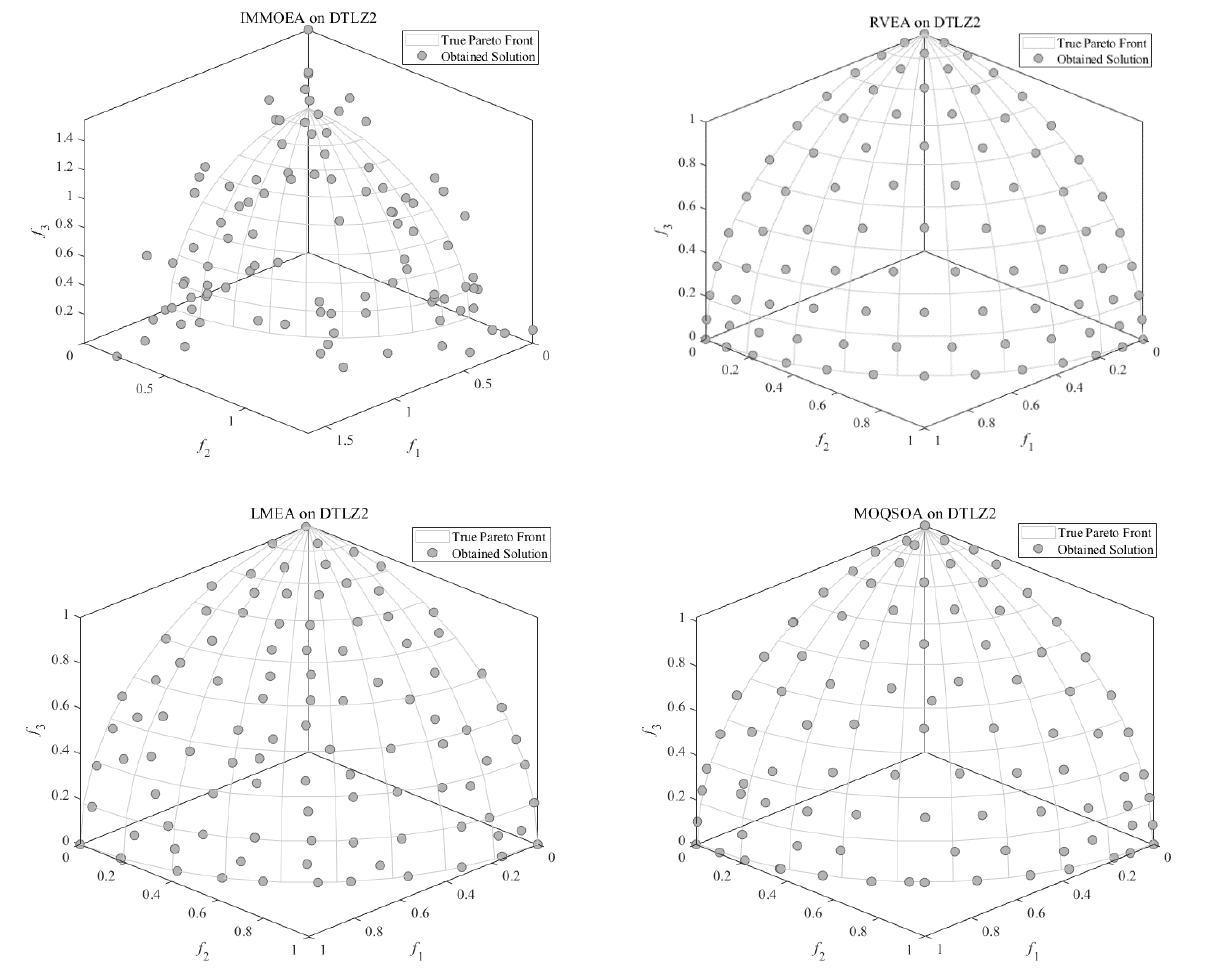
Figure 7. Pareto fronts of each algorithm for DTLZ2.